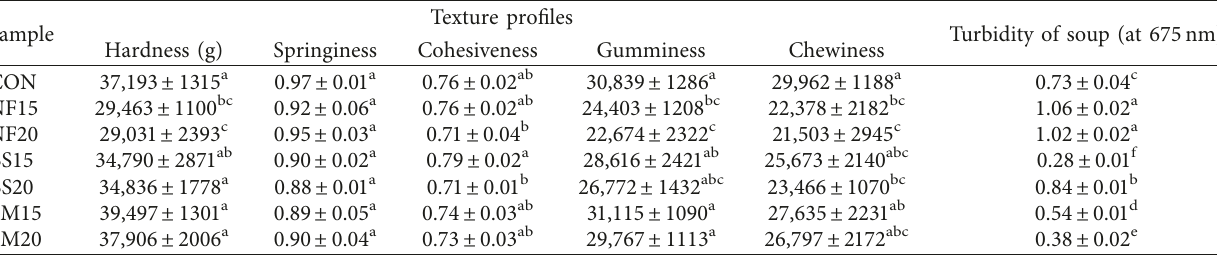
Table 2: Texture profiles and soup turbidity of rice and potato garaetteoks